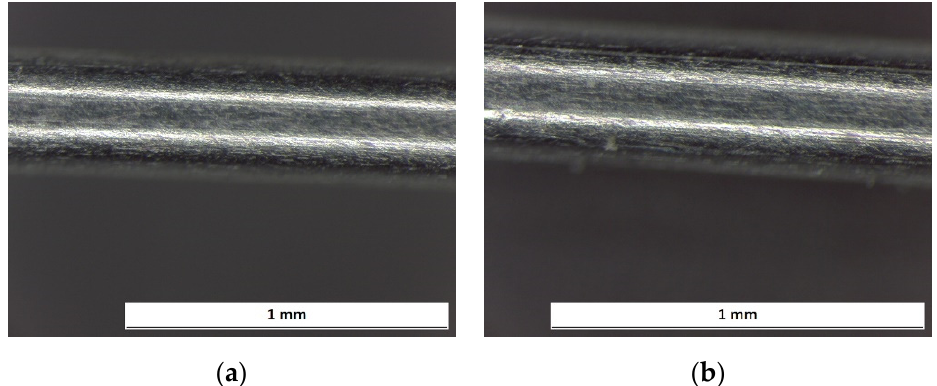
Figure 12. NiTi Memory archwire (American Orthodontics) in top view: ( a ) before the test; ( b ) after the test.